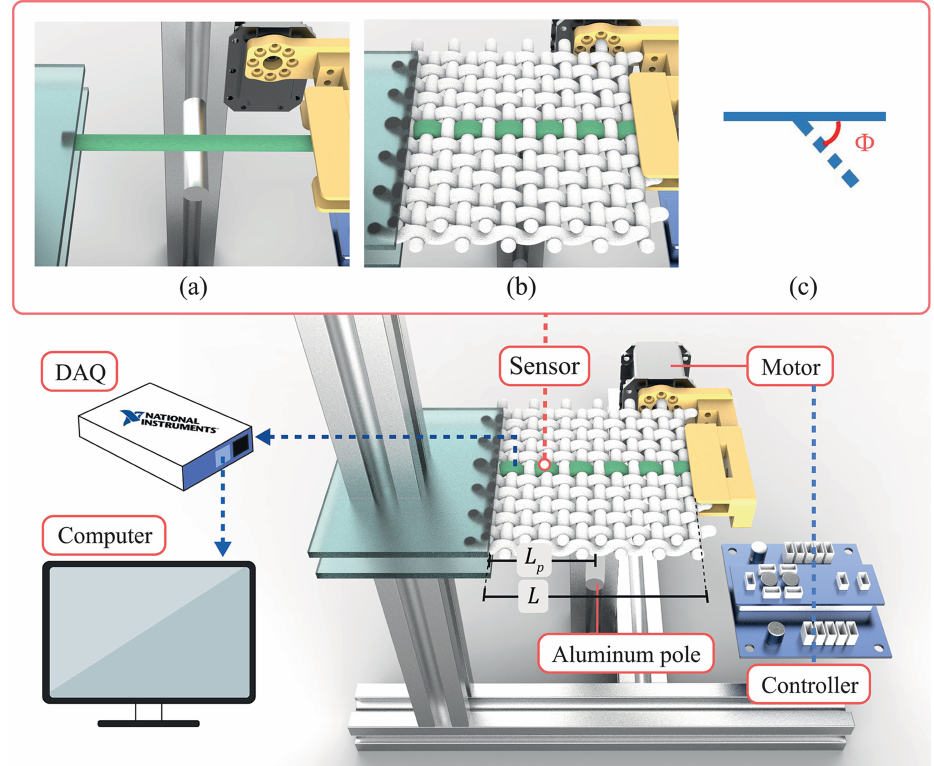
Figure 3. Experimental setup for applying flexural loading. The clamping conditions for the ( a ) piezoelectric sensor and ( b ) smart textile. ( c ) Flexural bending angle Φ